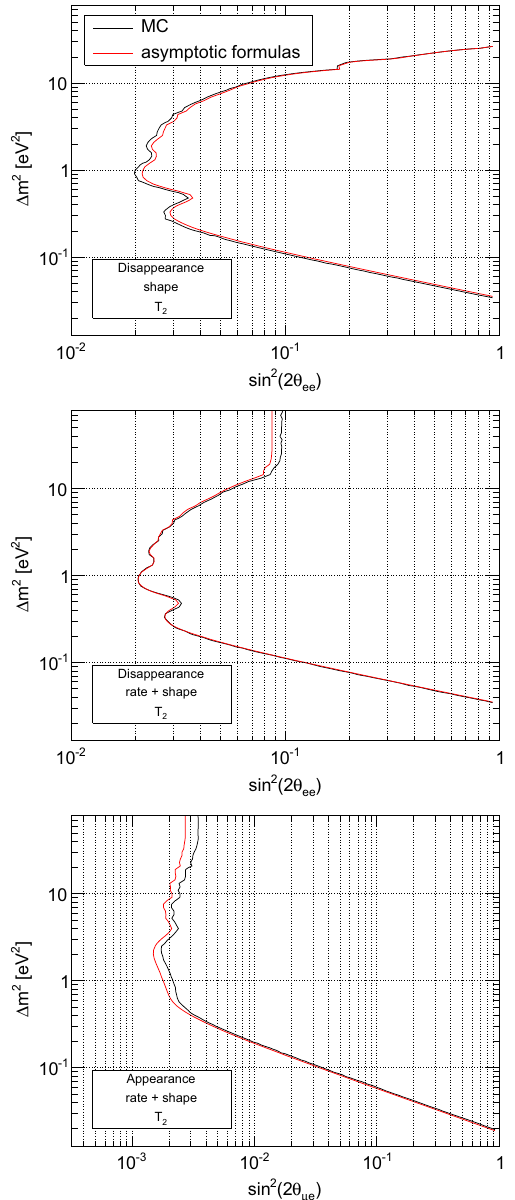
Fig. 9 Comparison between the 95% CL exclusion sensitivities com- puted using the test statistic distributions generated through Monte CarlotechniquesandtheiranalyticalapproximationbasedonWilksand Wald’s formulas and the Asimov data set. The sensitivities are shown for the toy disappearance and appearance experiment, using the shape and combined analysis. The sensitivities for a rate analysis fully agree with each other and are not shown